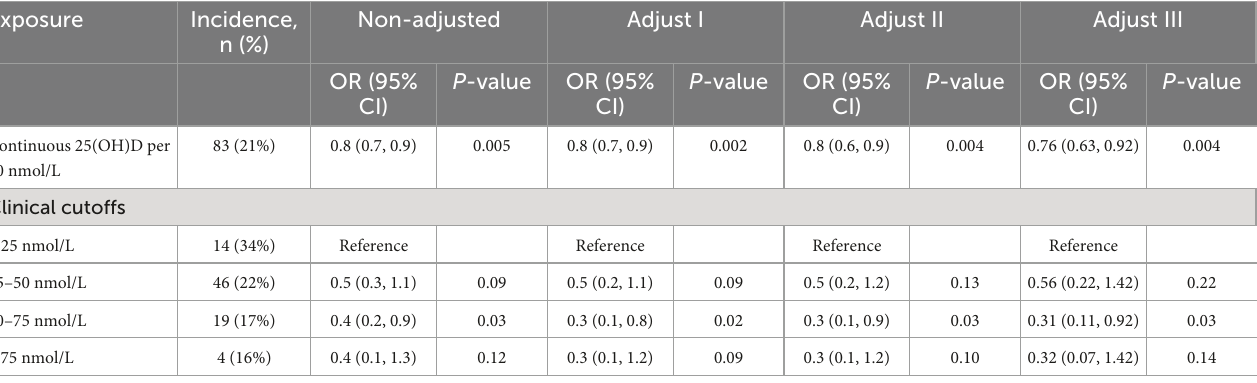
TABLE 2 Individual effect of serum 25(OH)D concentrations on CRC. Exposure Incidence,